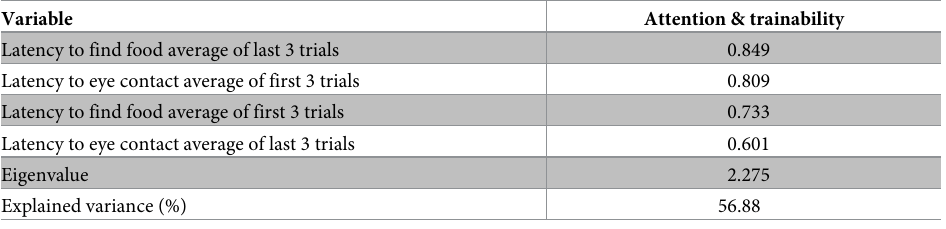
Table 12. Component derived from PCA on the variables measured in the clicker training for eye contact